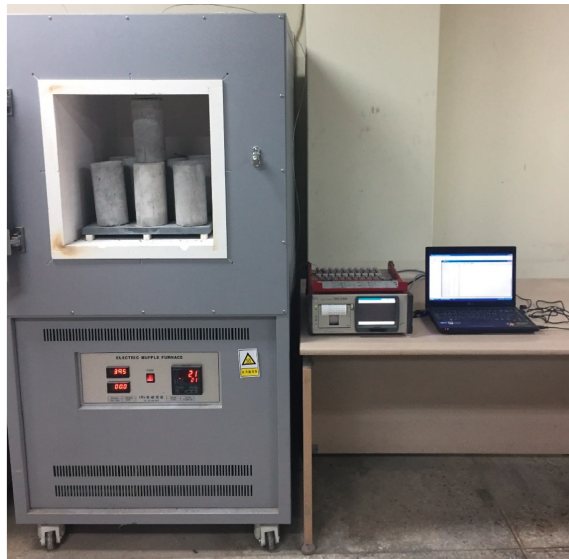
Figure 3: Test setup of the UHPC specimens in the furnace.